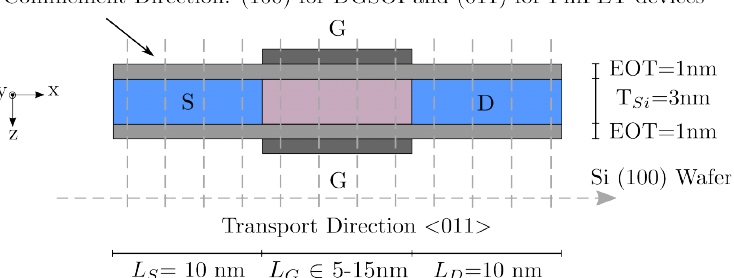
Figure 1. Schematic illustration of the Si DGSOI and FinFET structures with L G ranging from 5 nm to 15 nm. The rest of the parameters remains fixed: source length ( L S = 10 nm), drain length ( L D = 10 nm), Si thickness ( T Si = 3 nm), and Equivalent Oxide Thickness (EOT = 1 nm). The confine- ment direction for these devices on standard wafers [100] changed from (100) for DGSOI to (0¯11) for FinFET, whereas the transport direction < 011 > was the same for both. 1D Schrödinger equation was solved for each grid point in the transport direction, and BTE was solved by the MC method in the transport